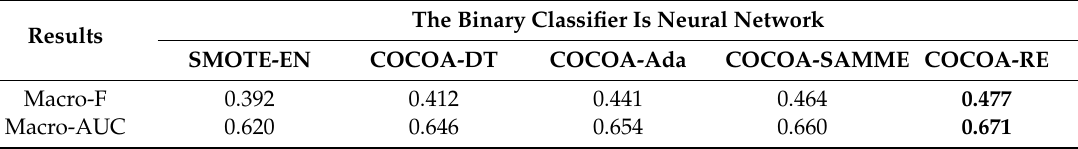
Table 5. The experimental results when the binary classifier is neural